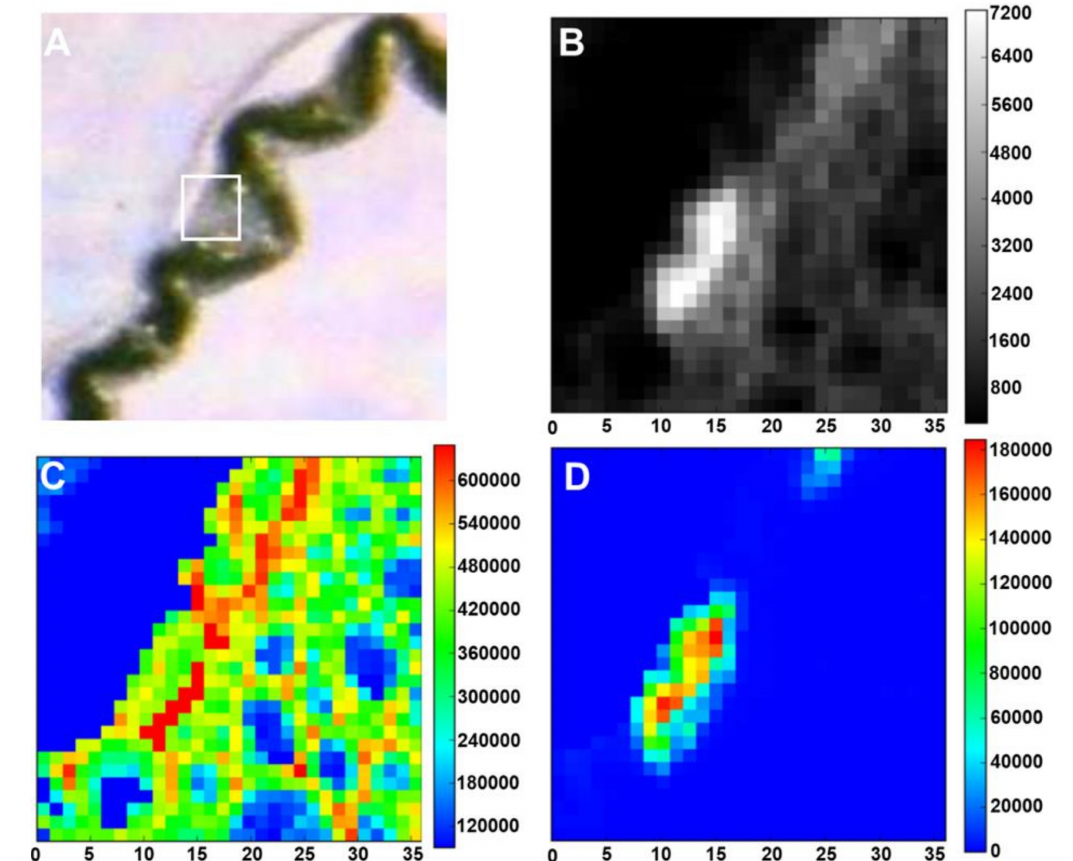
Figure 8. Light microscope and low-energy X-ray fluorescence (LEXRF) imaging of rice leaf tissue grown with 1 mM silicic acid. ( A ) Light microscope image showing the rice leaf sample; the white box highlights LEXRF imaging area. ( B ) Areal density image ( µ g · cm − 2 ) of sample. ( C ) LEXRF detection of oxygen ( µ g · g − 1 ) providing an overview of the plant tissue. ( D ) LEXRF detection of silicon ( µ g · g − 1 ) above the vascular bundle and coinciding with silica cells. LEXRF images show the amount of the relevant element (oxygen or silicon) in µ g · cm − 2 . The colour scale on the right side of each image is a scale of intensity of each element in that region of the sample. The LEXRF measurements were performed using the TwinMic X-ray fluorescence spectro-microscope at the Elettra Synchrotron Radiation Facility in Trieste. Quantification was performed according to Kump and Vogel-Mikuš [67]. X-axis is in µ